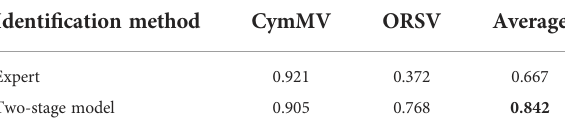
The bold value indicates the highest average